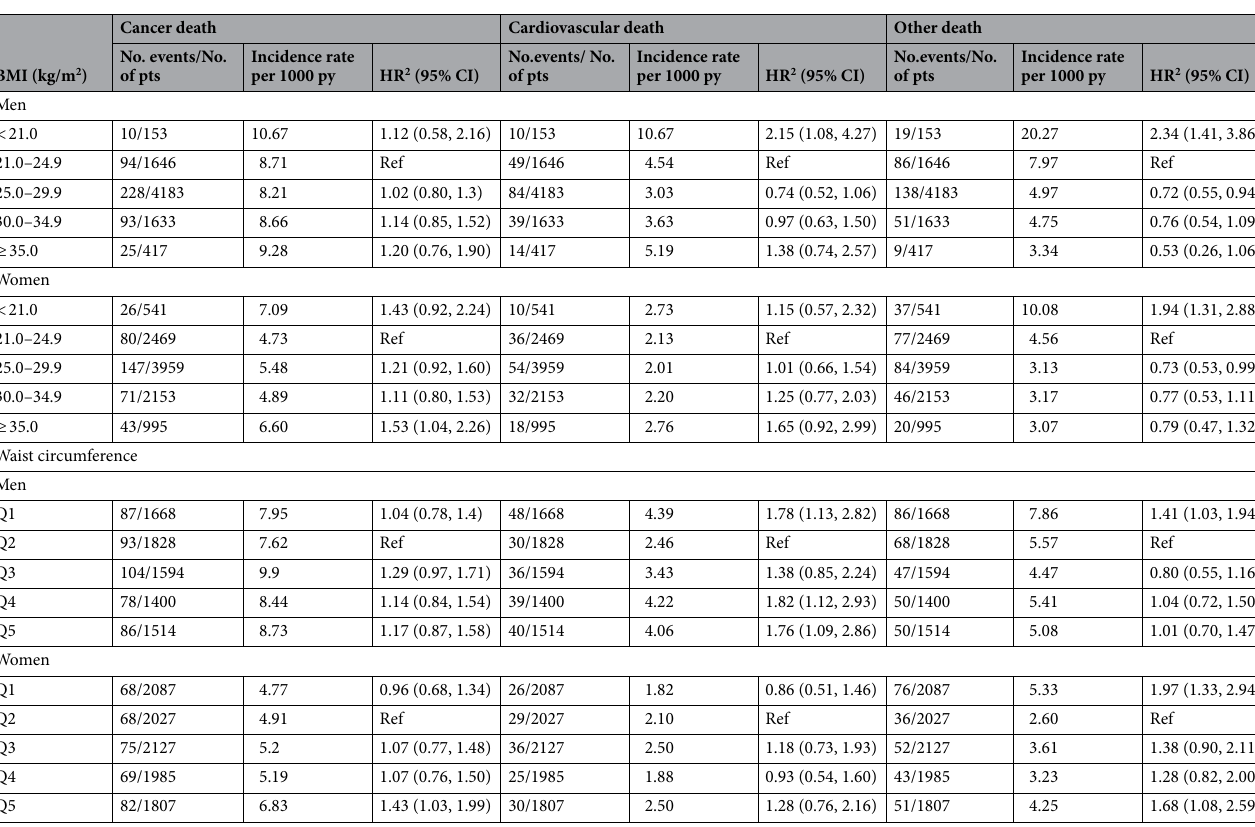
Table 4. Hazard ratio (95% CI) of cause-specific mortality 1 according to baseline BMI and waist circumference in men and women (BMI: n = 18,149, WC: n = 18,037). Waist Circumference Quintile Range (Mean) values for men: Q1:56–93 (88.13); Q2:94–99 (96.67), Q3:100–104 (101.97), Q4:105–110 (107.31), Q5: 111–153 (118.15); women: Q1: 44–82 (76.15), Q2: 83–89 (86.13), Q3: 90–96 (92.95), Q4: 97–104 (100.2), Q5: 105–180 (112.77). 1 Death related to specific causes including cancer (deaths that were related to primary or metastatic cancer), deaths from ischaemic CVD (any ischemic event [myocardial infarction, other coronary heart disease, sudden cardiac death, or ischemic stroke]), or other causes (deaths that were related to causes that were non-cancer or non-CVD [e.g. sepsis, chronic lung disease, dementia]). 2 HRs adjusted for age, smoking status, aspirin treatment arm, diabetes status (yes, no), level of education (< 12 years, ≥ 12 years), living status (at home alone, with others), alcohol consumption (current alcohol consumption, former/never), and longest amount of time walking outside home without any rest. BMI, body mass index; CI, confidence interval; HR, hazard ratio; py, person years; Ref.,